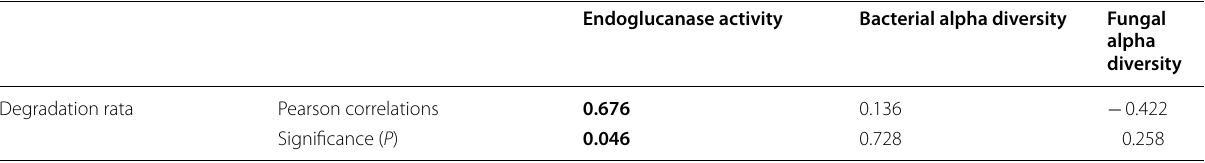
Table 2 Pearson correlations of degradation ratio with cellulose activity and microbial